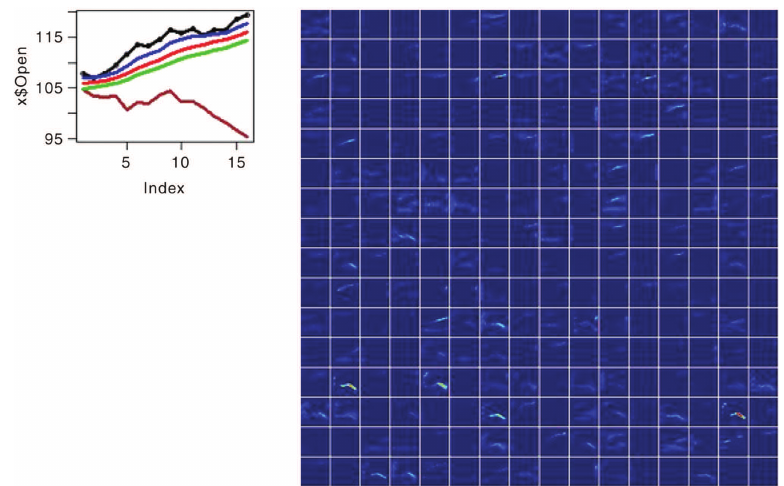
Figure 38: Visualization of the Second Convolution Layer with the Demo